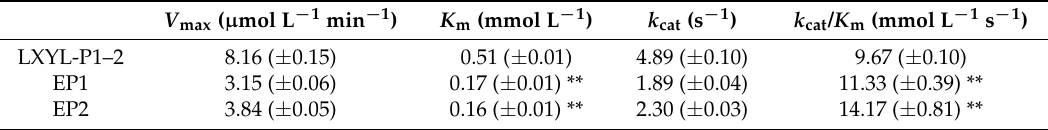
Table 3. Kinetic parameters for the hydrolysis of XDT by EP1 and EP2.